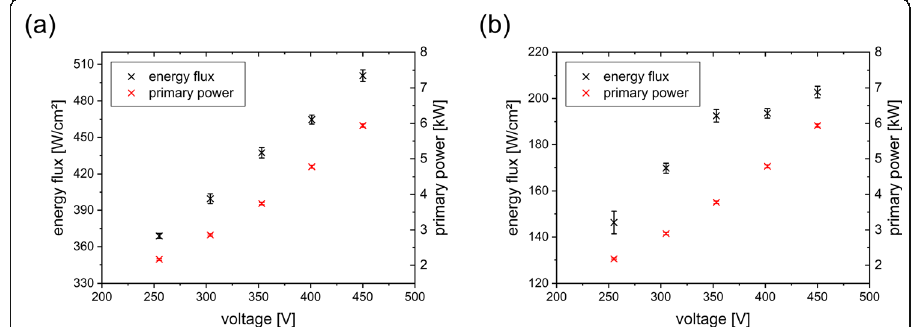
Fig. 3 Influence of the primary voltage on the energy flux ( a ) for nozzle head A and ( b ) for nozzle head B. These measurements were performed with a gas flow of 29 slm and at a probe distance of 4 mm to the